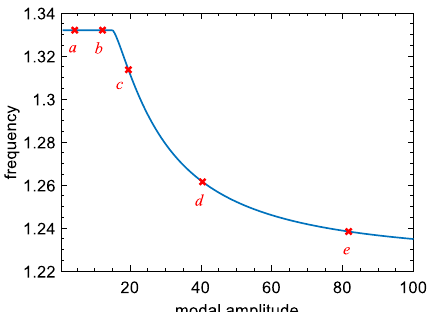
Figure 6. Frequency vs. the modal amplitude curve of a dry-friction system.